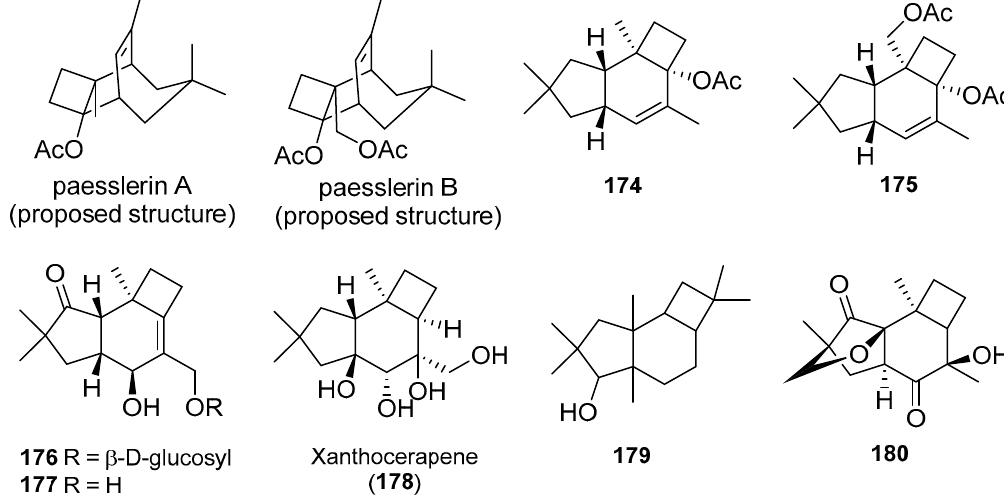
Figure 27. Structures of protoilludanes 174 – 180 isolated from marine and plant sources.